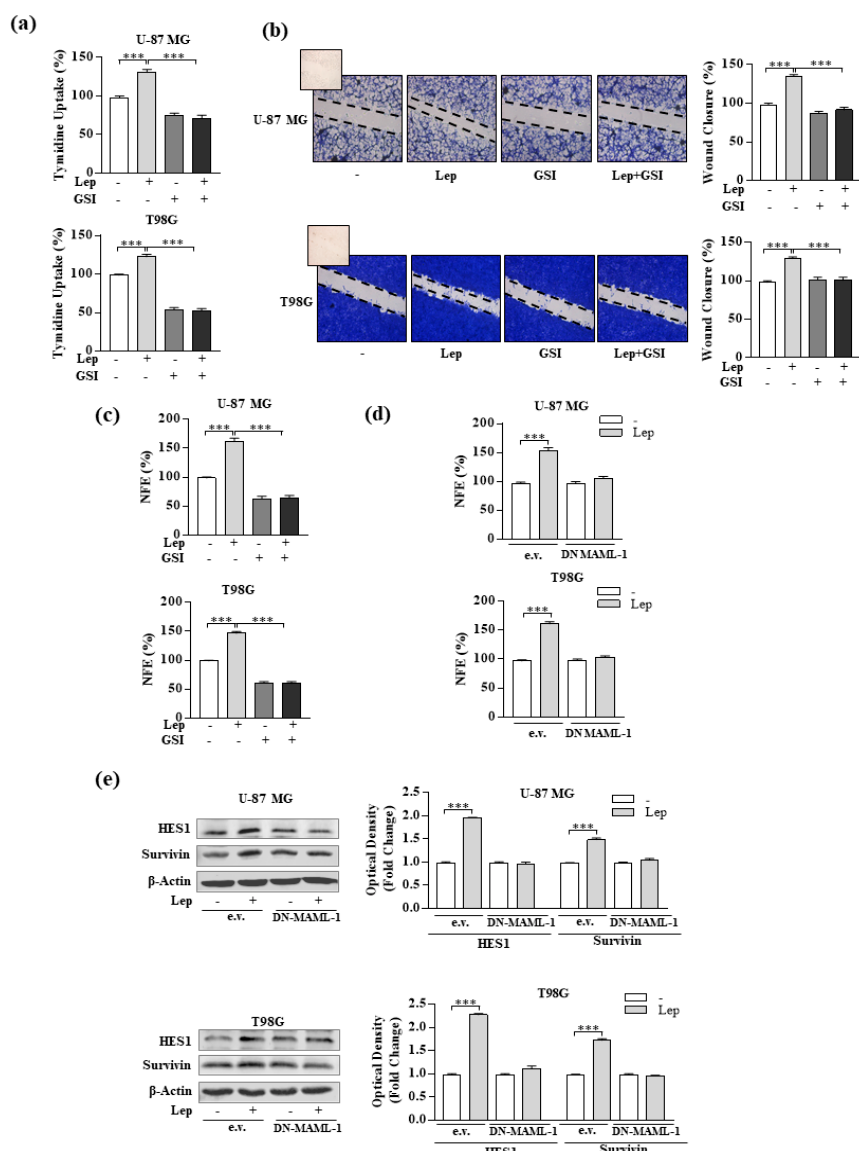
Figure 6. E ff ects of Notch inhibition on leptin-induced cells’ proliferation, migration, and stem cell activity in GBM cells. ( a ) Cell proliferation was determined by the [3H] thymidine incorporation assay after 24 h of treatment with vehicle (-), leptin (Lep, 500 ng / mL), and γ -secretase inhibitor (GSI, 1 µ mol / L) alone or in combination. ( b ) Wound healing assays in U-87 MG and T98G cells treated for 12 h with vehicle (-), leptin (Lep, 500 ng / mL), and γ -secretase inhibitor (GSI, 1 µ mol / L) alone or in combination. Images are representative of three independent experiments. The histograms represent the relative percentage of wound closure calculated by ImageJ software version 1.51q. Small squares, time 0. Original magnification, × 10. ( c ) NFE in U-87 MG and T98G cells cultured in the presence of vehicle (-), leptin (Lep, 500 ng / mL), and γ -secretase inhibitor (GSI, 1 µ mol / L) alone or in combination. ( d ) NFE in U-87MG and T98G cells transiently transfected with an empty vector (e.v.) or the DN-MAML-1 plasmid, and treated with vehicle (-) or leptin (Lep, 500 ng / mL). ( e ) Expression levels of HES1 and survivin, in U-87 MG and T98G cells transiently transfected with an empty vector (e.v.) or DN-MAML-1 for 24 h and then treated with vehicle (-) or leptin (Lep, 500 ng / mL) for 12 h. β -Actin was used as the loading control. The histograms represent the means ± SD of three separate experiments in which band intensities were evaluated in terms of optical density arbitrary units and expressed as a fold change vs. vehicle-treated samples, which were assumed to be 1. The histograms represent the means ± SD of three separate experiments, each performed in triplicate. *** p <